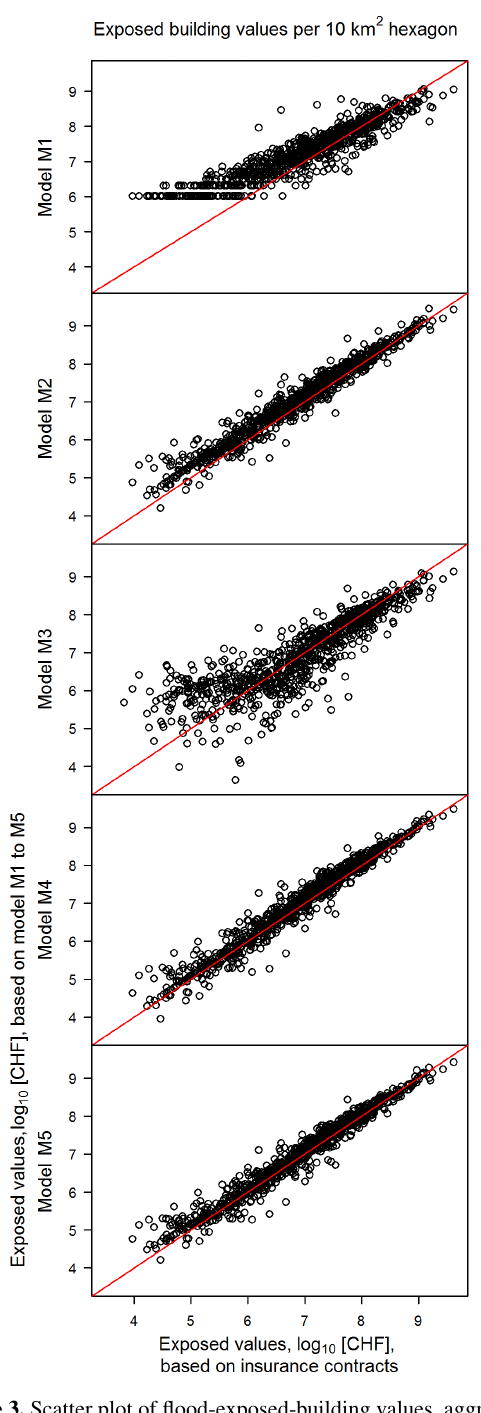
Figure 3. Scatter plot of flood-exposed-building values, aggregated to regular hexagons with a surface area of 10km 2 . The sums based on models M1 to M5 ( y axis) are plotted against the sums based on the direct application of the values from the spatially referenced building insurance contracts ( x axis). The red lines indicate the 1 : 1 relation. The values are log 10 transformed and sums below 10 4 CHF are not shown.